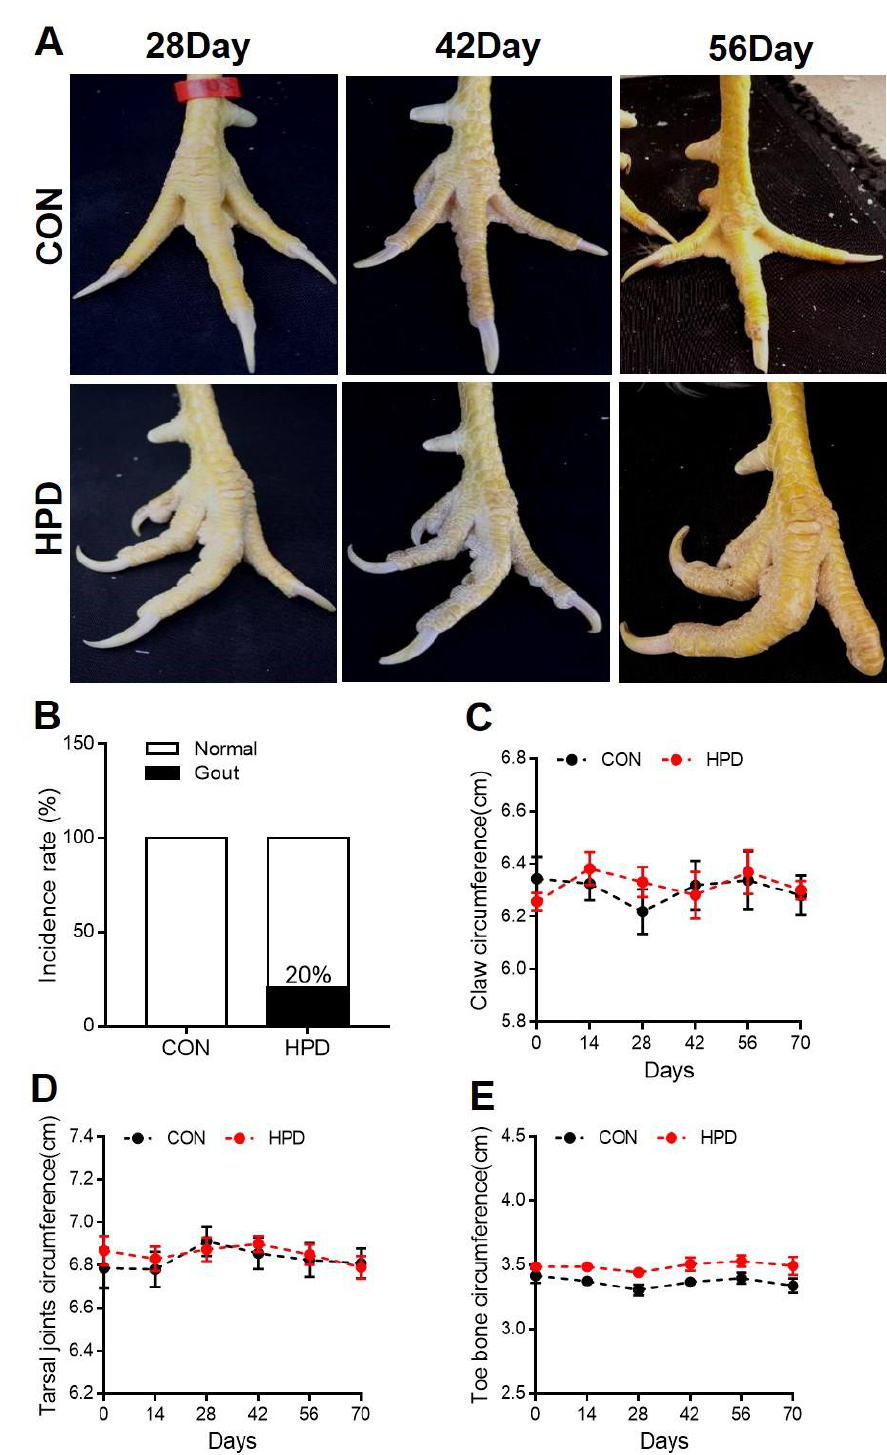
Figure 4. HPD induces an abnormal claw morphology in chickens. ( A ) Representative images of chicken claws after being fed for 28, 42, and 56 days. ( B ) Gout incidence rate. ( C ) Claw circumference, ( D ) tarsal joint circumference, and ( E ) toe bone circumference of chicken. Values are presented as the mean ±